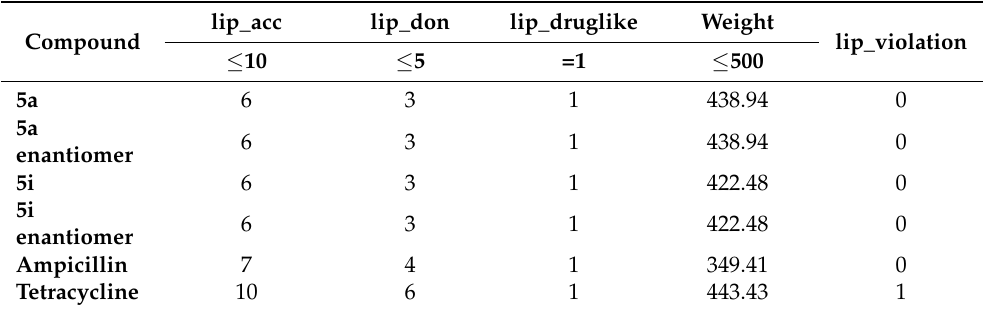
Table 8. Results of the Lipinski parameters of compounds 5a , 5i, 5i enantiomer , Ampicillin and